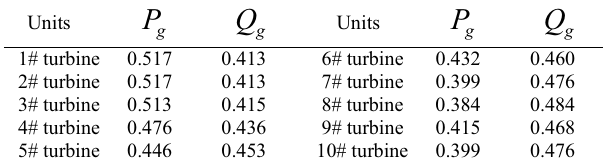
Fig.6. Active power generated by wind farm